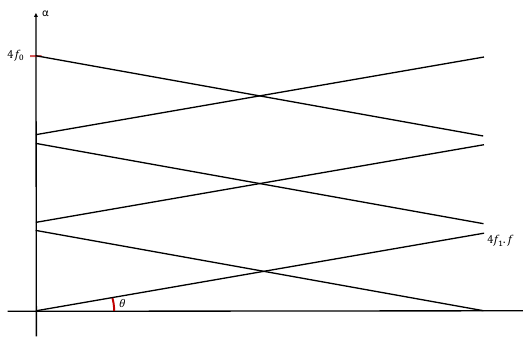
Figure 10. The theoretical relations between “ α ” and “ f ” for the model (9) when U ( t ) is